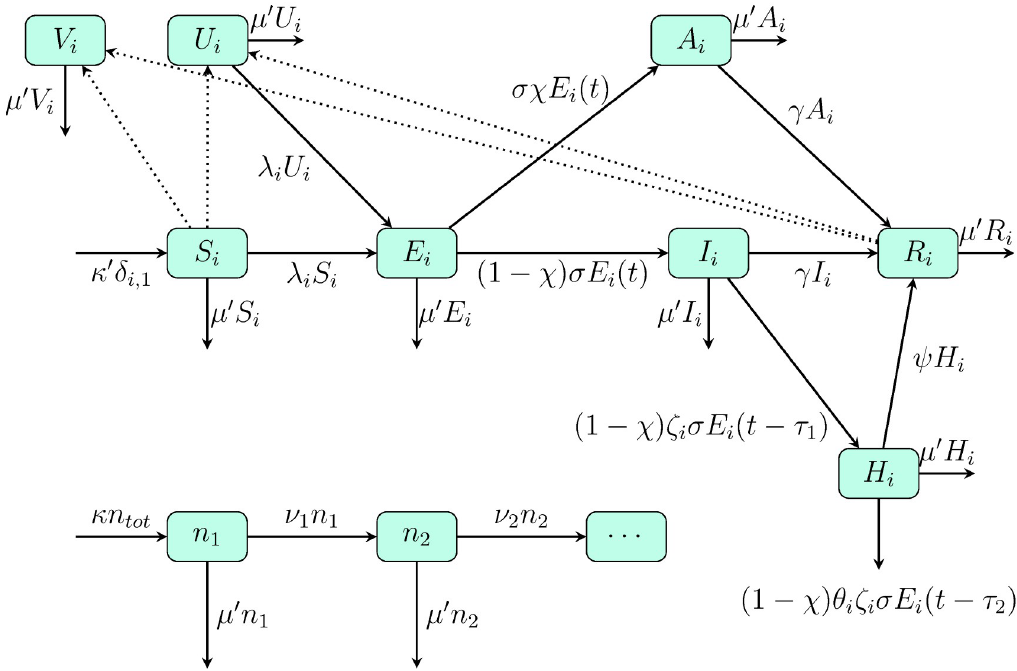
Fig 2. Epidemiological SEIAHRV model flow chart. The continuous arrows represent rates between variables. The dotted lines indicate the proportion with respect to N 0 of vaccine shots (see below). In the diagram μ 0 � μN / N 0 and κ 0 � κ N / N 0 , with μ and κ the natural death and birth rates in the population, respectively, and N the current total population. The proportion in the age group i with respect to N 0 is denoted by n i and the aging rate ν i from group i is given by the inverse of the time span of the age group in the time unit used. All parameters are given in S1-S3 Tables in S1 File.